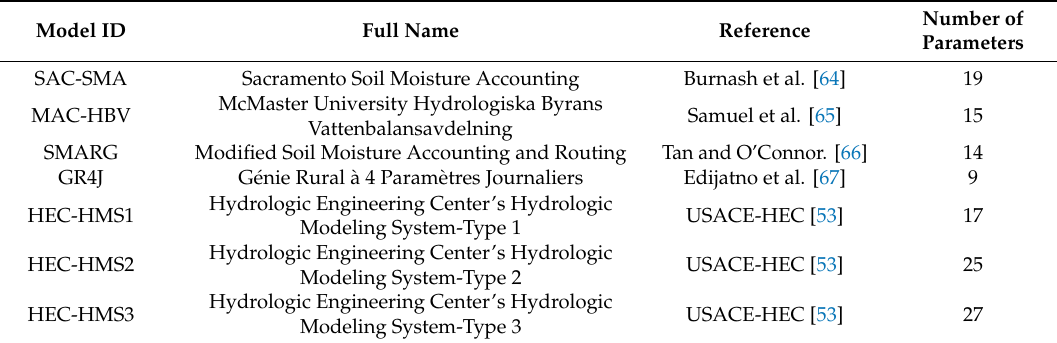
Table 3. Hydrologic models used in this